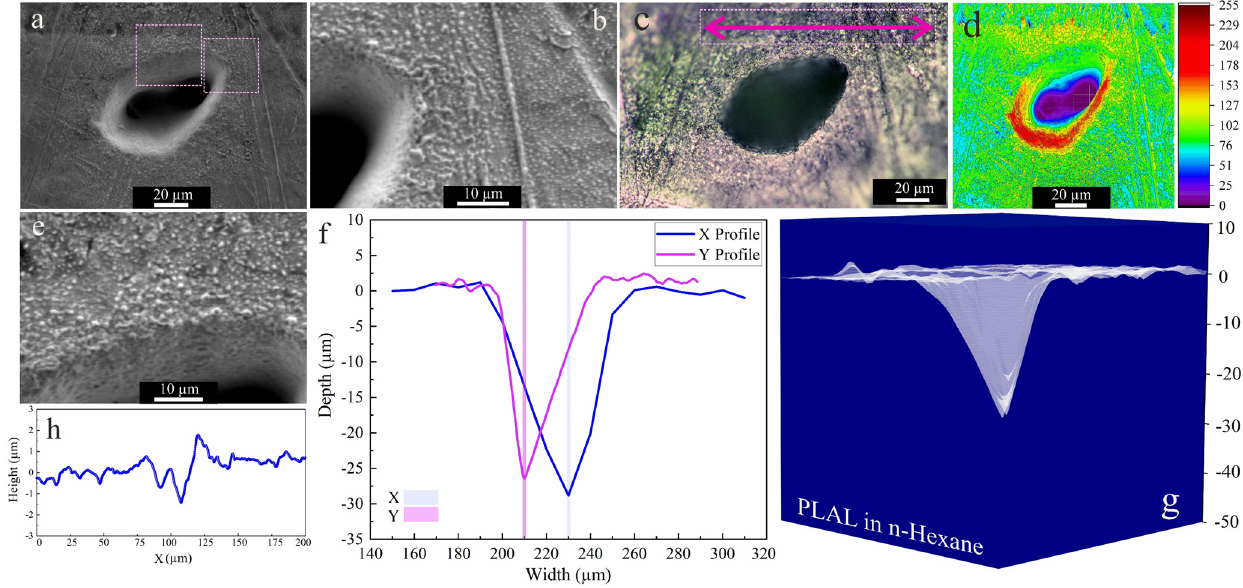
Figure 5. Morphology of a crater formed by PLAL of Au ‐ coated Ni in n ‐ hexane ( N = 1000, 1 kHz, E = 250 μ J). ( a , b , e ): SEM images and magnified areas of redeposited frozen droplets and crater edges; ( c ): optical microscopy of the crater (the green arrow indicates the scan of roughness); ( d ): 3D reconstructed image of an SEM image; ( f , g ): depth profile analyses of femtosecond ‐ laser ‐ drilled holes and 3D mapping plot; and ( h ): a surface profile curve close to the crater.